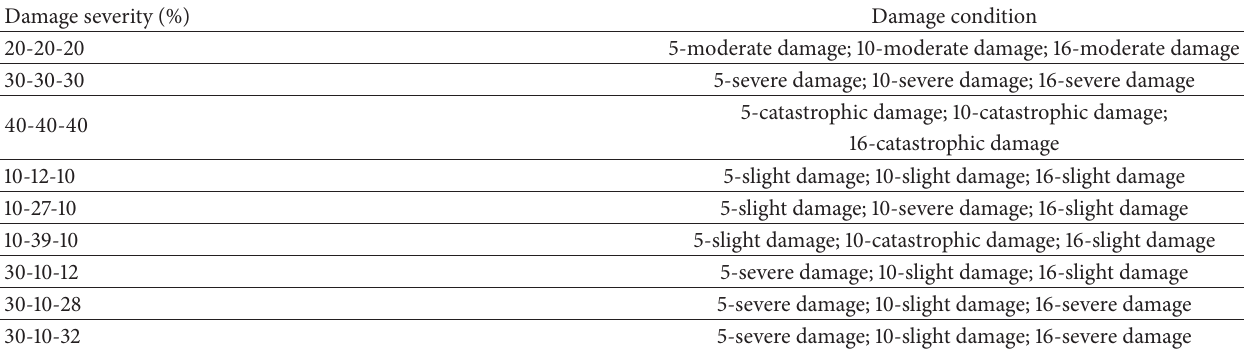
Table 10: Identification results of fuzzy systems for multiple